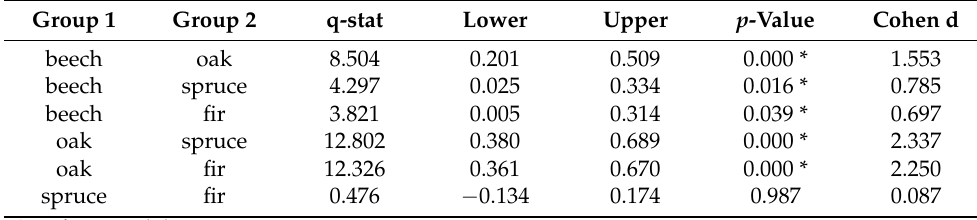
Table 5. Results of Tukey’s HSD post hoc analysis of inhalable mass concentration